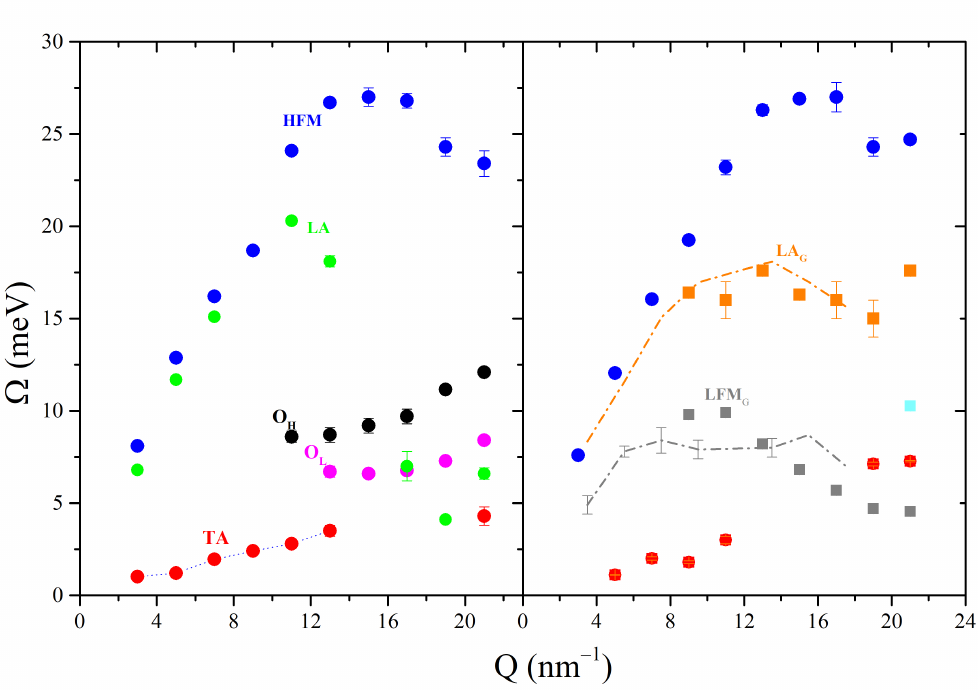
Figure 6. Left and right plot display, respectively, the dispersion curves detected in pure ice (dots) and in the frozen suspensions (squares). The dash-dotted orange line in the right plot represents the dispersion curve of the only (longitudinal acoustic) mode observable in liquid gold [13,28,29], while the corresponding gray line is the transverse Au phonon dispersion observed in our IXS measurement on a liquid AuNP suspension [4]. Each mode is associated with a color and labeled in either of the two plots with the acronyms of the same color, whose meaning is explained in the main